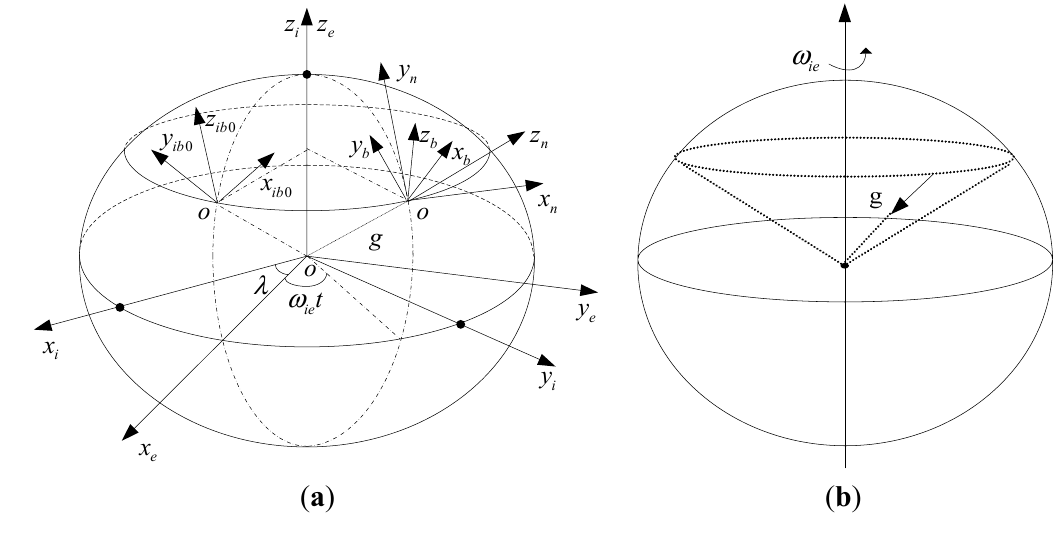
Figure 2. ( a ) The different coordinate frames; ( b ) Conical movements of the gravity vector in inertial